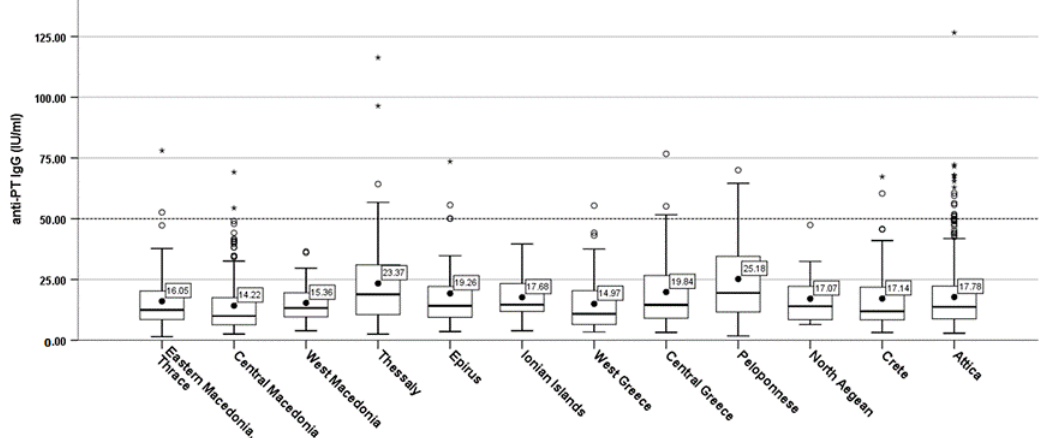
Figure 3. Anti-PT IgG (mean) by region.